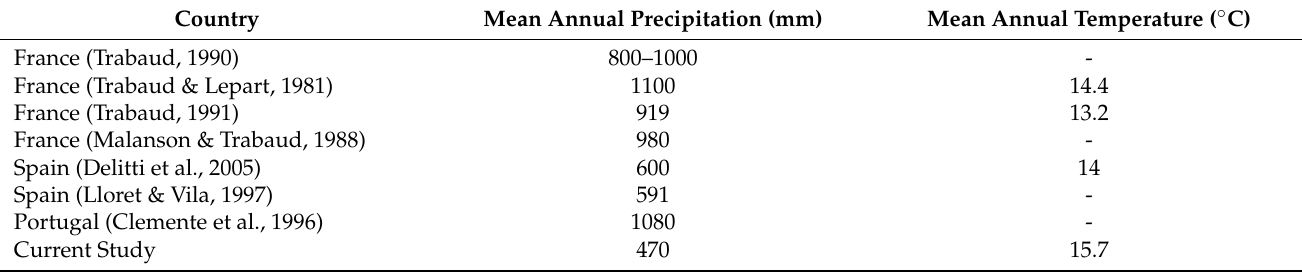
Table 8. Mean annual precipitation and temperature values reported in studies of Q. coccifera recovery after fire in the western